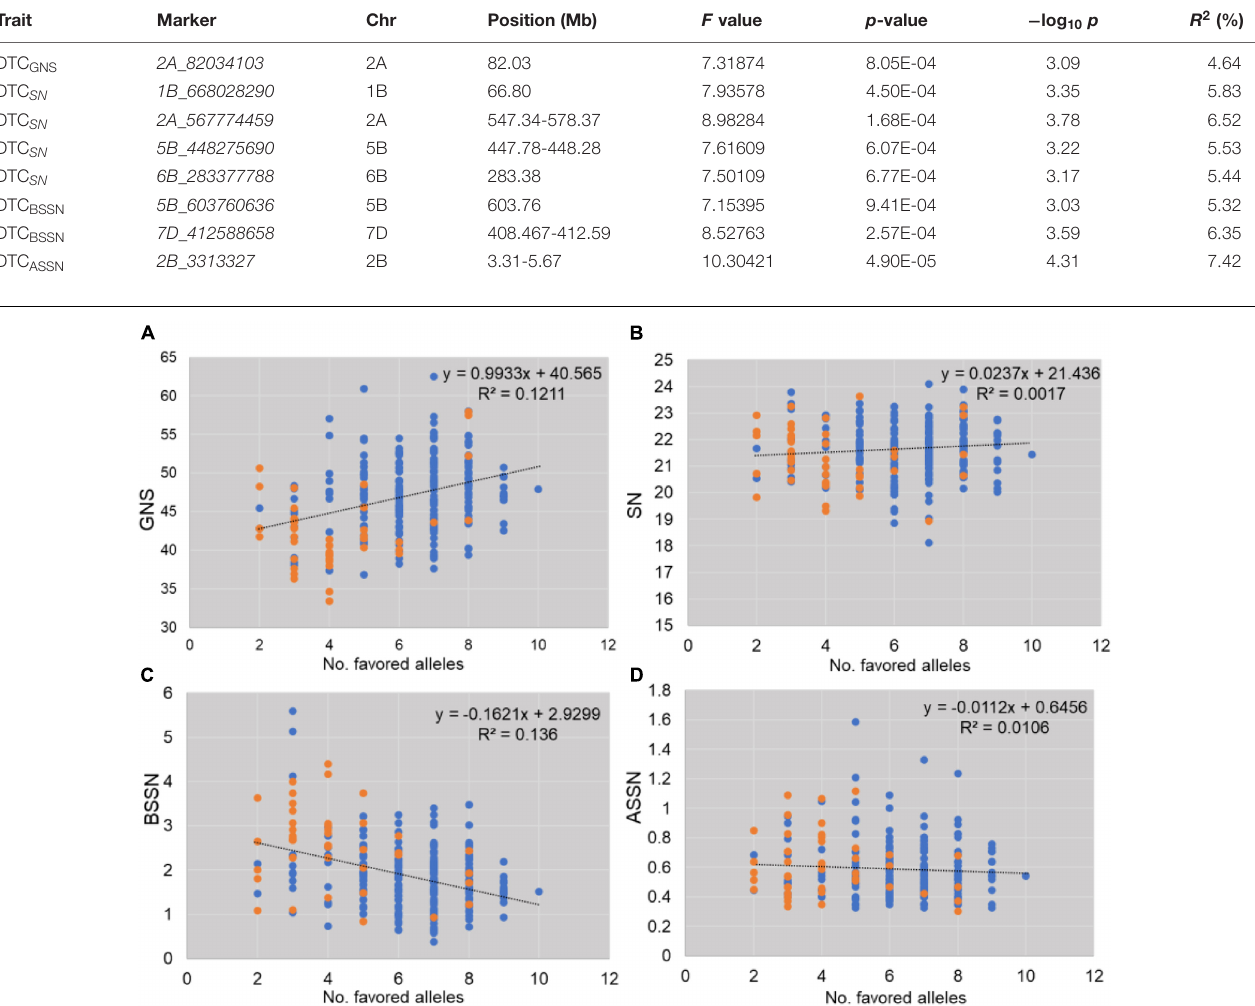
TABLE 3 | List of significant ( p < 0.001) marker-DTC trait associations detected by GWAS using the MLM model. Trait Marker Chr